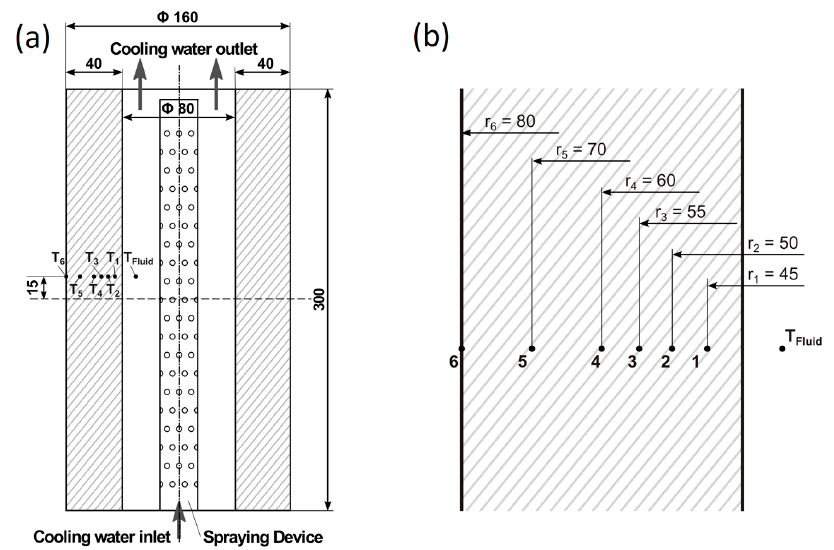
Figure 17. The longitudinal section of thick-walled cylinder with installed thermocouples: entire cross-section ( a ), temperature measurement area ( b ).